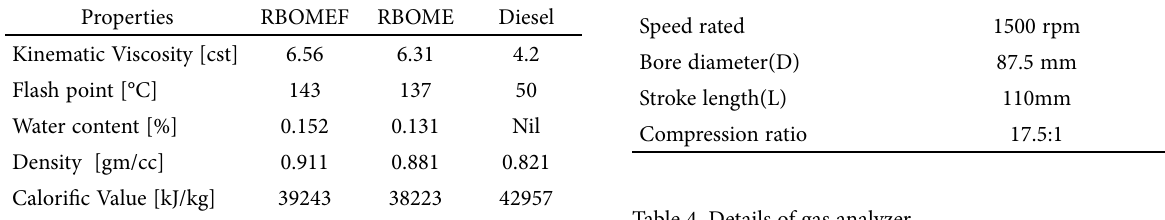
Table 4. Details of gas